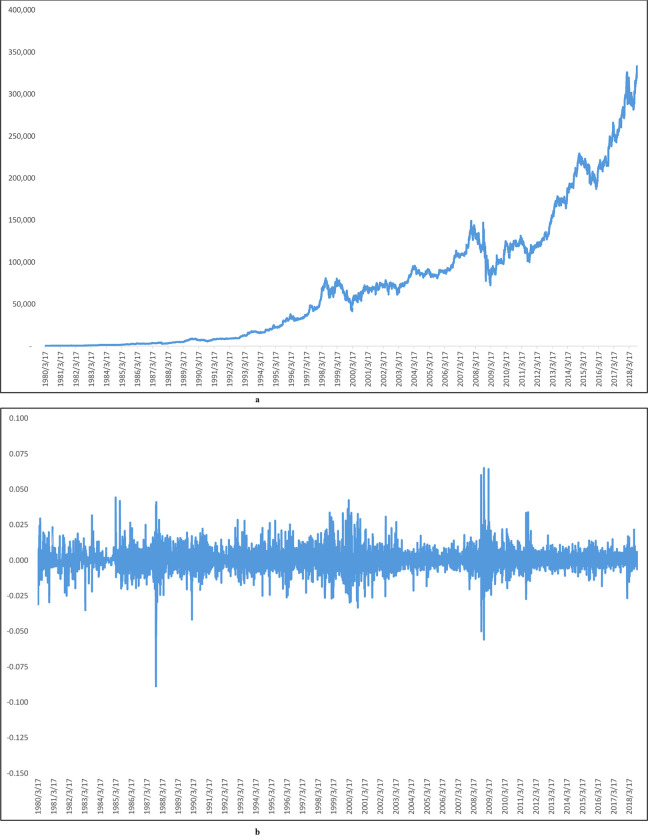
a: The trend of Berkshire A stock price, b: Berkshire A stock price returns. Fig 1A shows Berkshire A stock price trend from 1980/3/17-2018/09/28. The figure shows that Berkshire A stock price rises very quickly. It also shows that the return volatility for Berkshire A is also relatively high. Fig 1A shows that the stock price fell significantly during the period of the recent financial crisis, but the stock price also rises faster after the financial crisis. Fig 1B shows the return of Berkshire A stock price from 1980/3/17-2018/09/28. Fig 1B shows that the volatility of stock price return was significantly higher in 1987 and 2008 than in other periods.